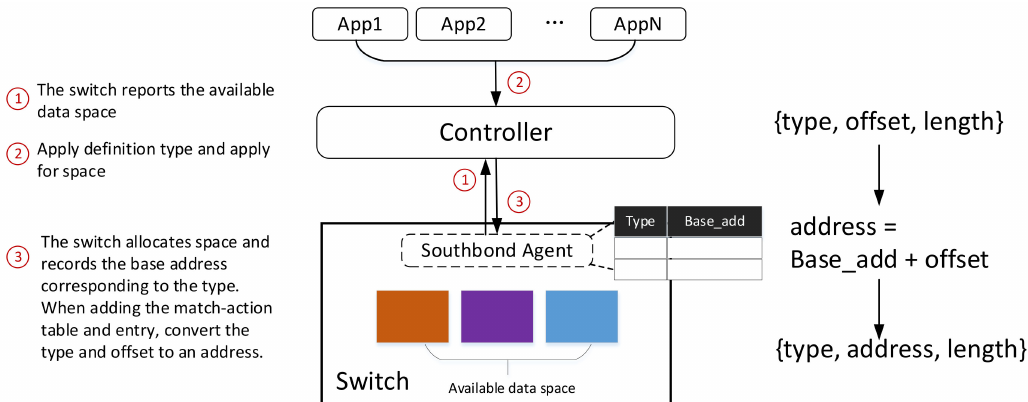
Figure 5. Converting type and offset to data locations while adding the match-action table and